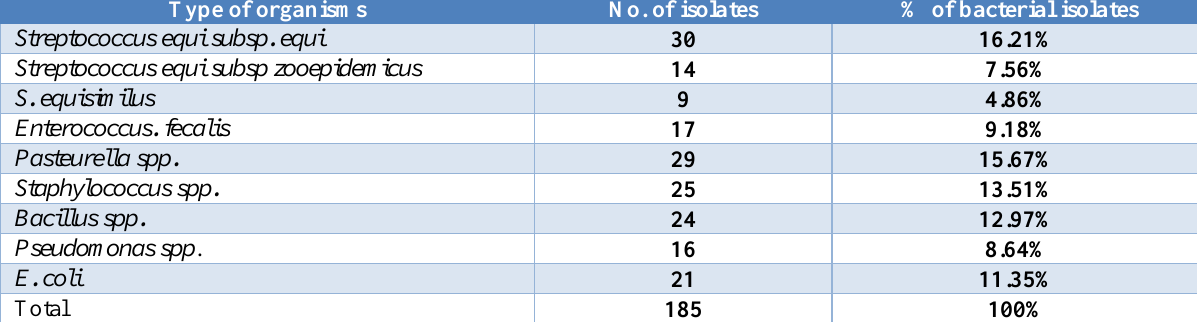
Table, 2: Results of bacterial isolates obtained from nasal swabs and pus samples cultures of diseased horses. Type of organisms No. of